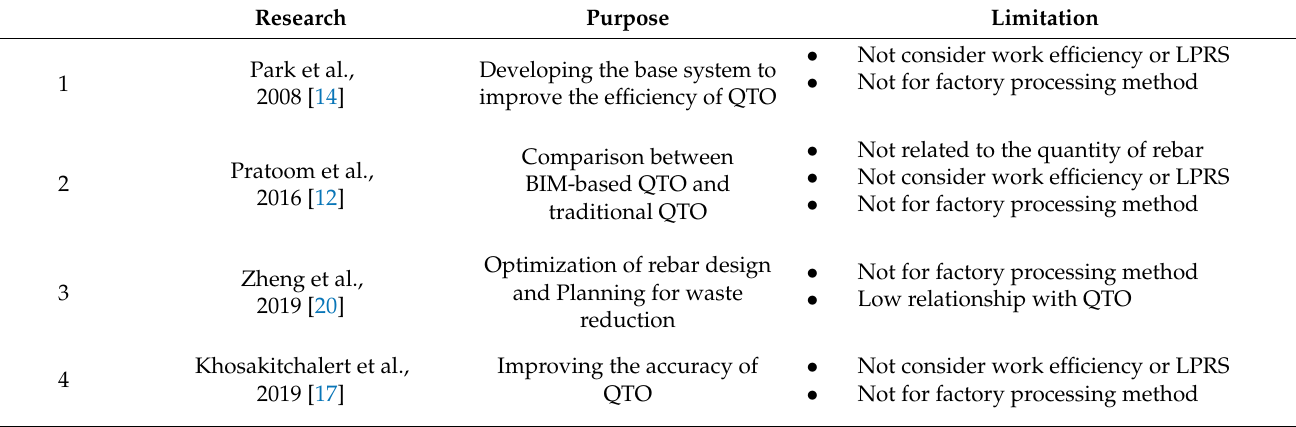
Table 1. Previous studies related to 3D BIM-based QTO and minimizing rebar